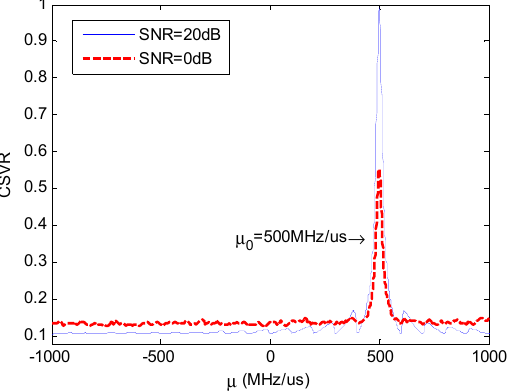
Figure 3. Chirp singular value ratio (CSVR) spectrum under different signal-to-noise ratio (SNR).